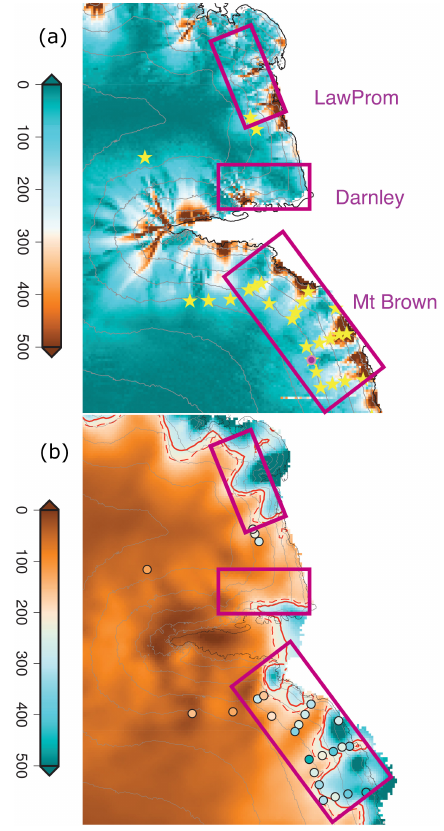
Figure 5. Panel (a) shows a further enlargement of Fig. 3b (eleva- tion change in metres), with the existing Mt Brown South ice core record identified (fuchsia dot), while panel (b) shows a further en- largement of Fig. 1b (annual snowfall accumulation with < 250 and < 200mmyears − 1 IE shown as solid red and dashed red lines re-